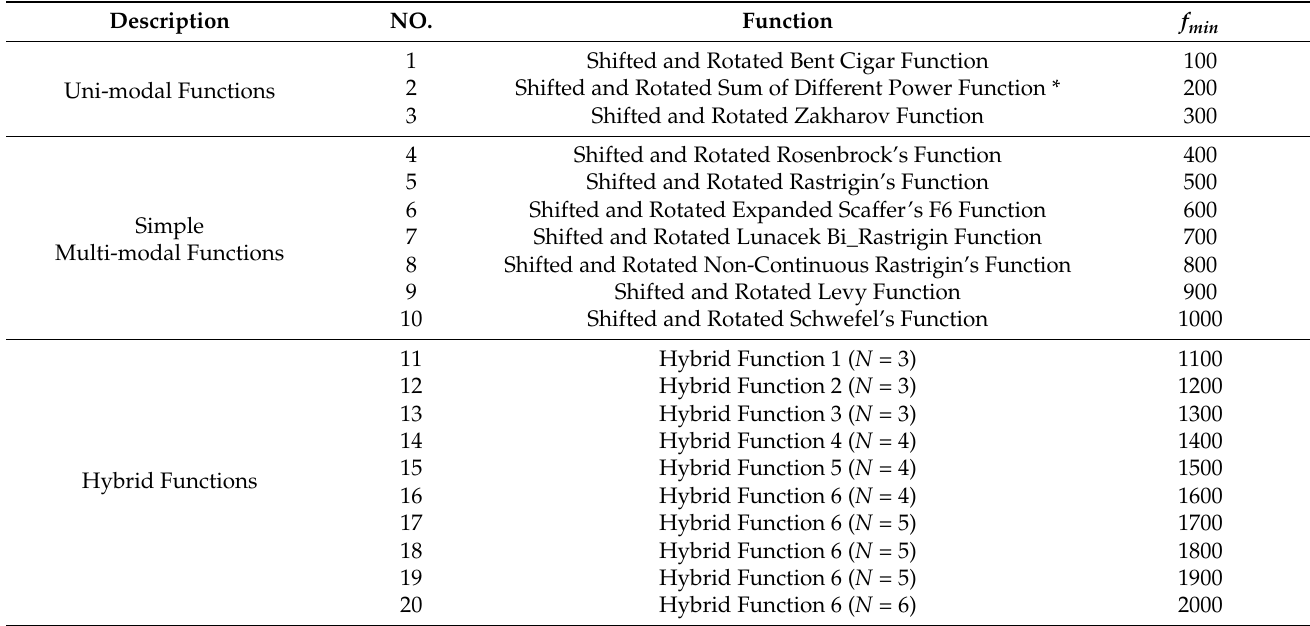
Table 3. Summary of the CEC2017 test